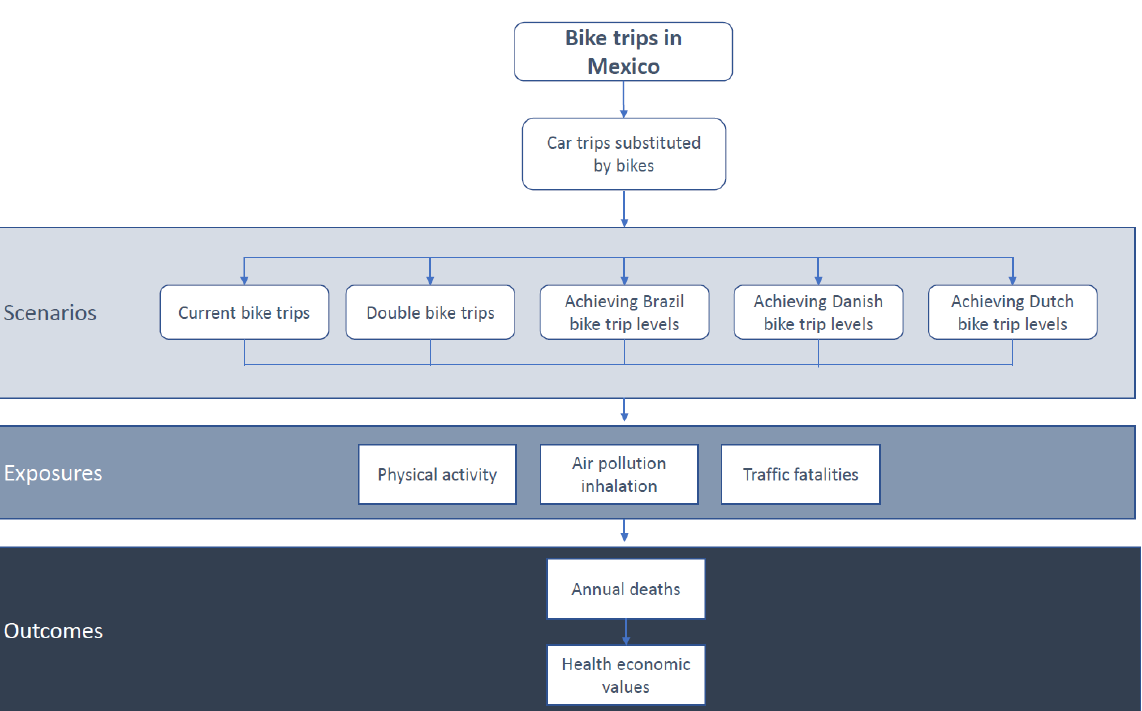
Figure 1. Conceptual framework of the study.